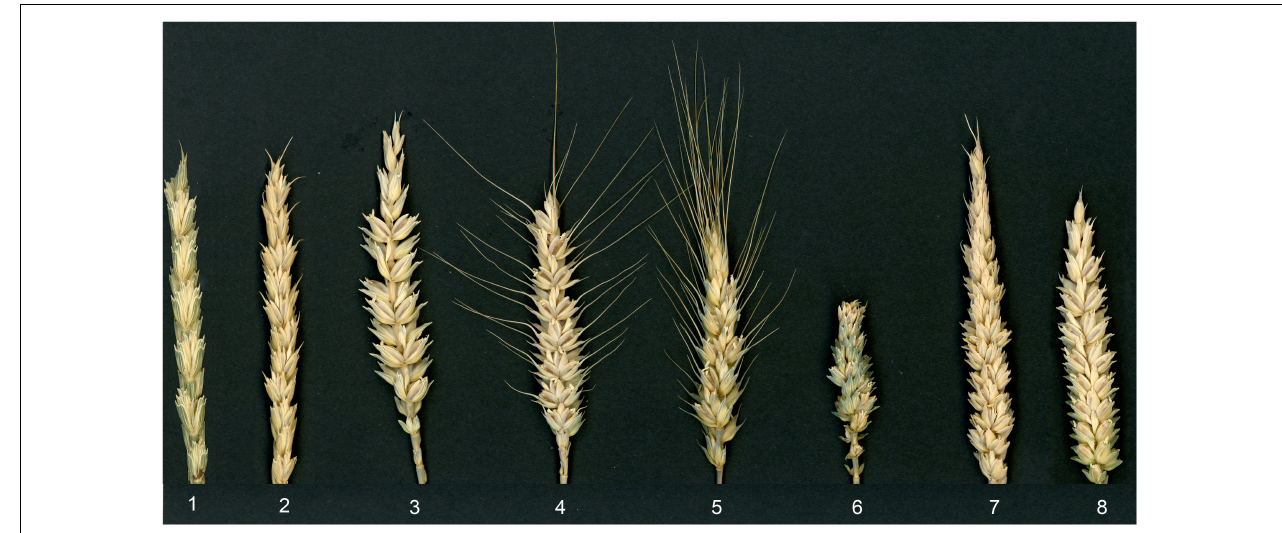
FIGURE 1 | The morphology of the spikes of Alcedo, the amphiploid between Alcedo and Aegilops markgrafii , and six wheat addition lines carrying the alien chromosomes from Ae. markgrafii. 1, amphiploid, 2, AI(B); 3, AII(C); 4, AIII(D); 5, AV(E); 6, AIV(F); 7, AVIII(G); 8, Alcedo. TABLE 1 | Karyotypic characteristics of Aegilops markgrafii chromosomes and the spike agronomic traits of the six Alcedo- Ae . markgrafii S740-69 disomic addition lines. Addition lines Length ( µ m) of Ae . markgrafii chromosome Arm ratio (L:S) Spike traits